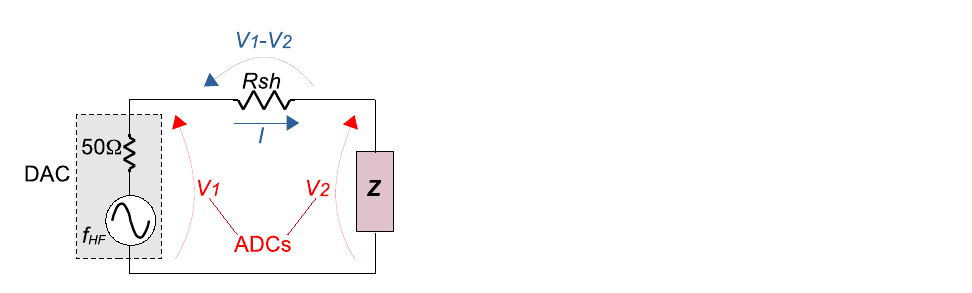
Figure 1. Measurement circuit for frequency sweep of the impedance under test Z , using general purpose ADCs and DACs and a shunt resistor R sh —Redraw based on